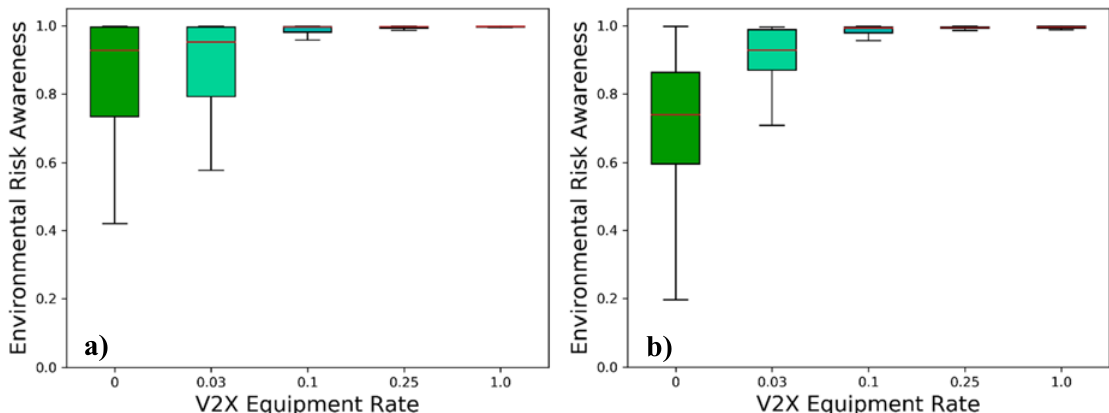
Figure 14. Environmental Risk Awareness for ( a ) the low-density scenario and ( b ) the high-density scenario, showing typical data range (whiskers), interquartile range (boxes) and median (red-colored line).